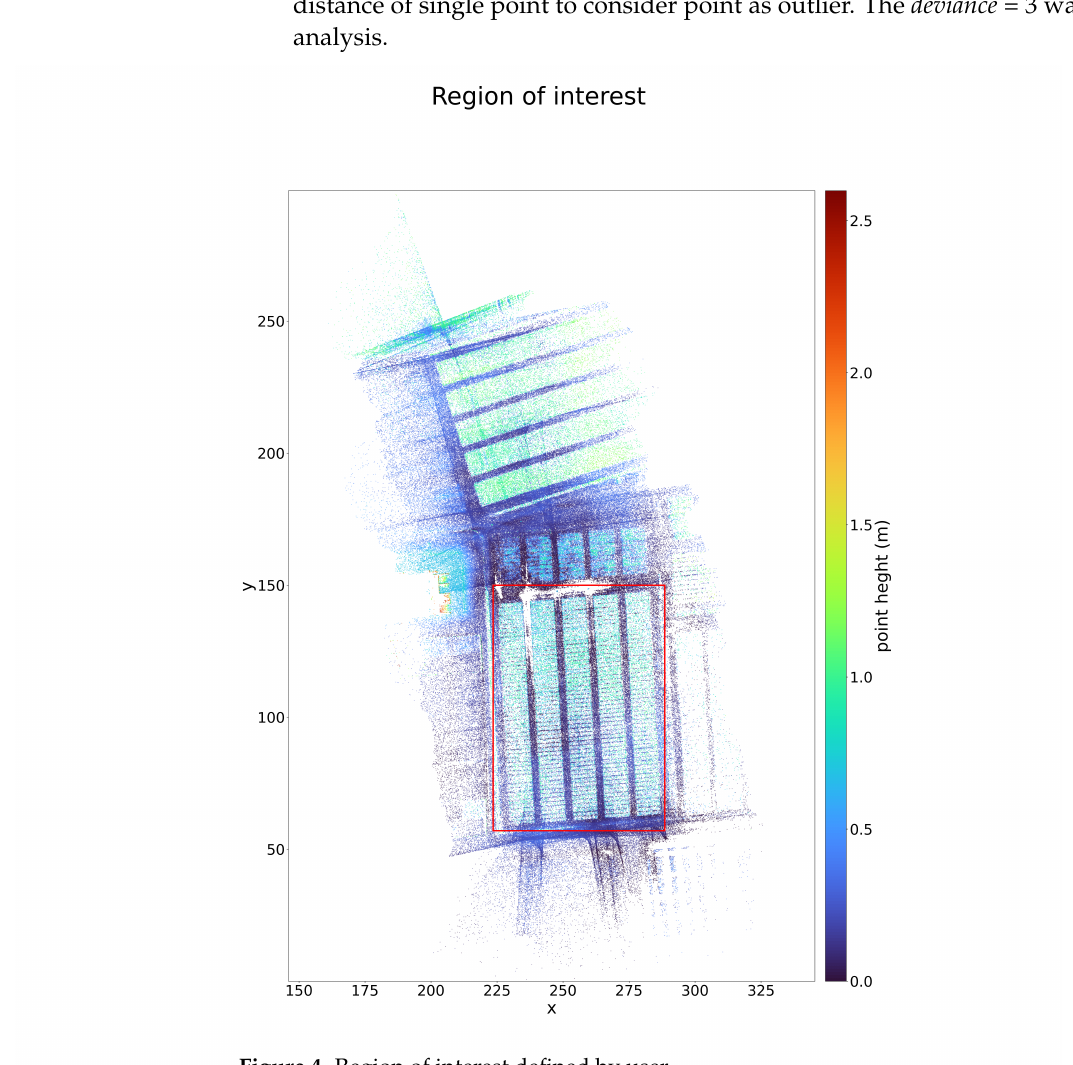
Figure 4. Region of interest defined by